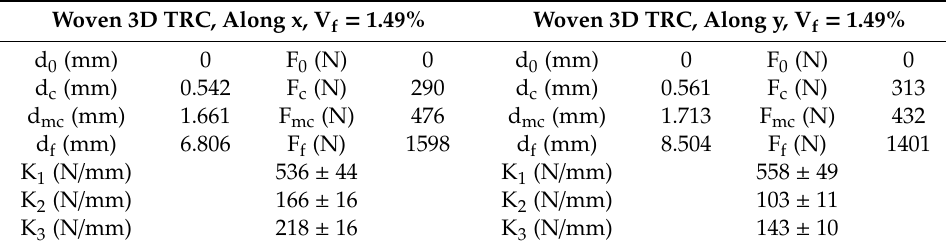
Figure 15. All flexural experimental curves in x- and y-direction for the woven 3D TRC layup, as well as averaged curves. Table 9. Averaged flexural experimental parameters for the woven 3D TRC layup. Woven 3D TRC, along x, V f = 1.49%. Woven 3D TRC, along y, V f = 1.49%